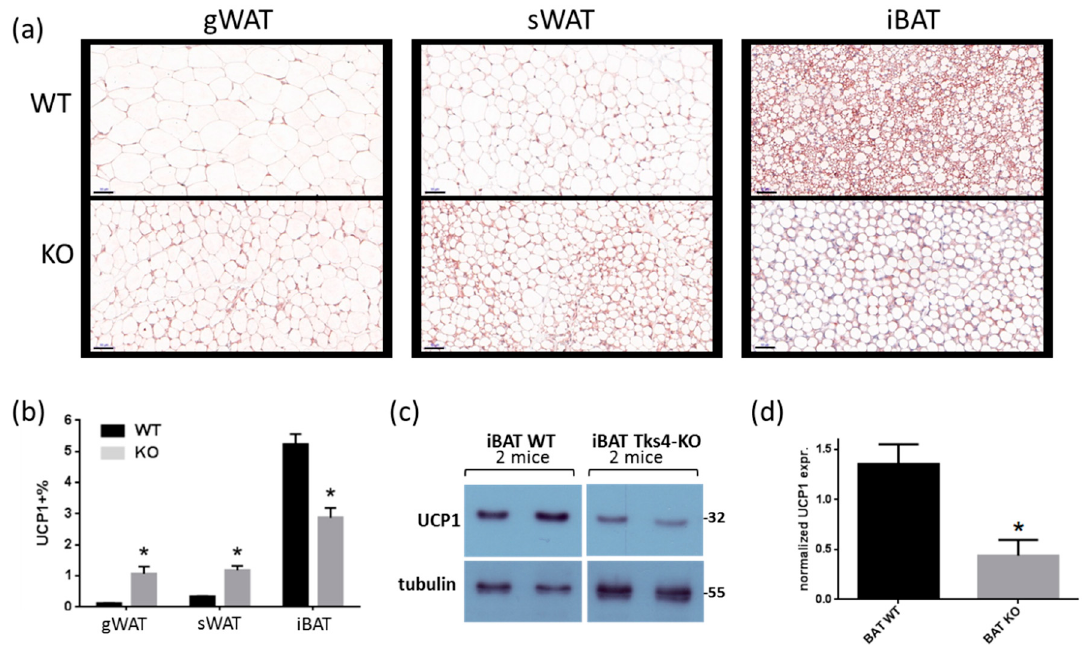
Figure 3. Adipogenic phenotypes of Tks4-KO mice. ( a ) Representative images of uncoupling protein 1 (UCP1)-stained gWAT, sWAT, and iBAT sections isolated from WT and Tks4-KO mice. Scale bar: 50 µ m. ( b ) Quantification of the UCP1 + frequency. Sections from six WT and six Tks4-KO mice were analyzed, and four di ff erent fields-of-view from each tissue sample were included. All data are presented as the mean ± SEM, and t -tests were applied to test statistical significance. * indicates p < 0.05. ( c ) Western blot analysis of the UCP1 protein abundance in iBAT isolated from WT and Tks4-KO mice. Tubulin was used as the loading control. A representative blot of two WT and two Tks4-KO iBAT samples is shown. ( d ) Quantification of the UCP1 western blotting results for the iBAT samples isolated from four WT and four Tks4-KO mice from two independent experiments.